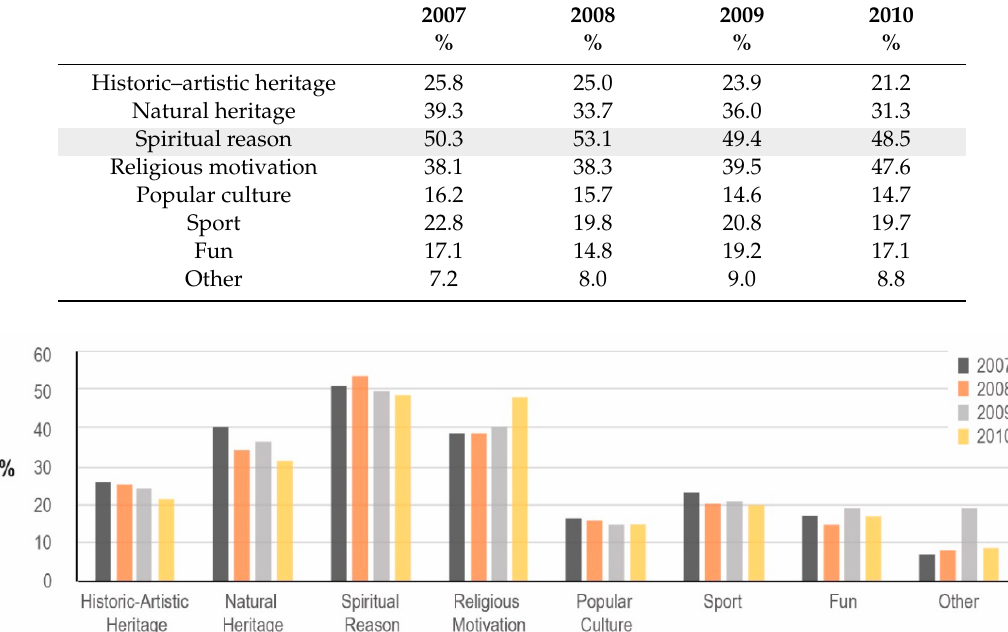
Figure 7. Main reasons for doing The Way. Own preparation based on data from Pilgrim Profile Reports, Observatory of The Way. (CETUR and SA Xacobeo 2007–2010).